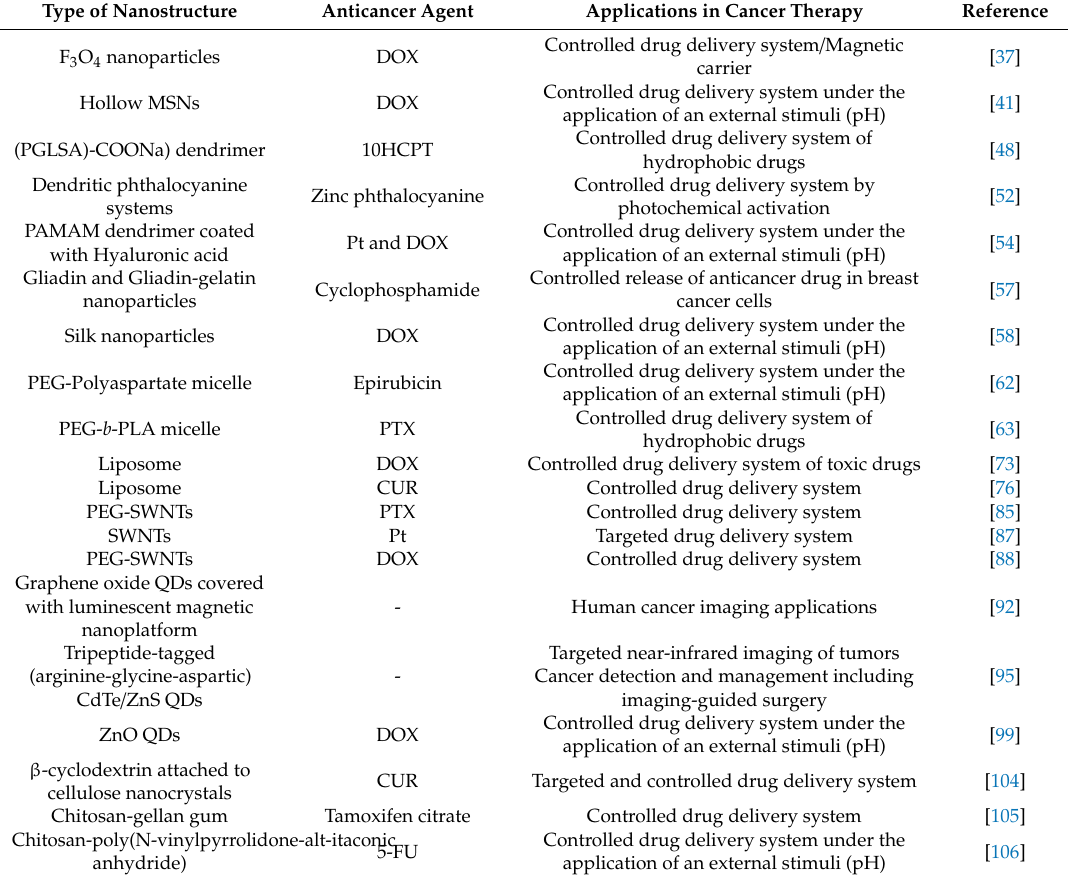
Table 2. Di ff erent NCs used in cancer therapy, the loaded anticancer agent and their applications in cancer